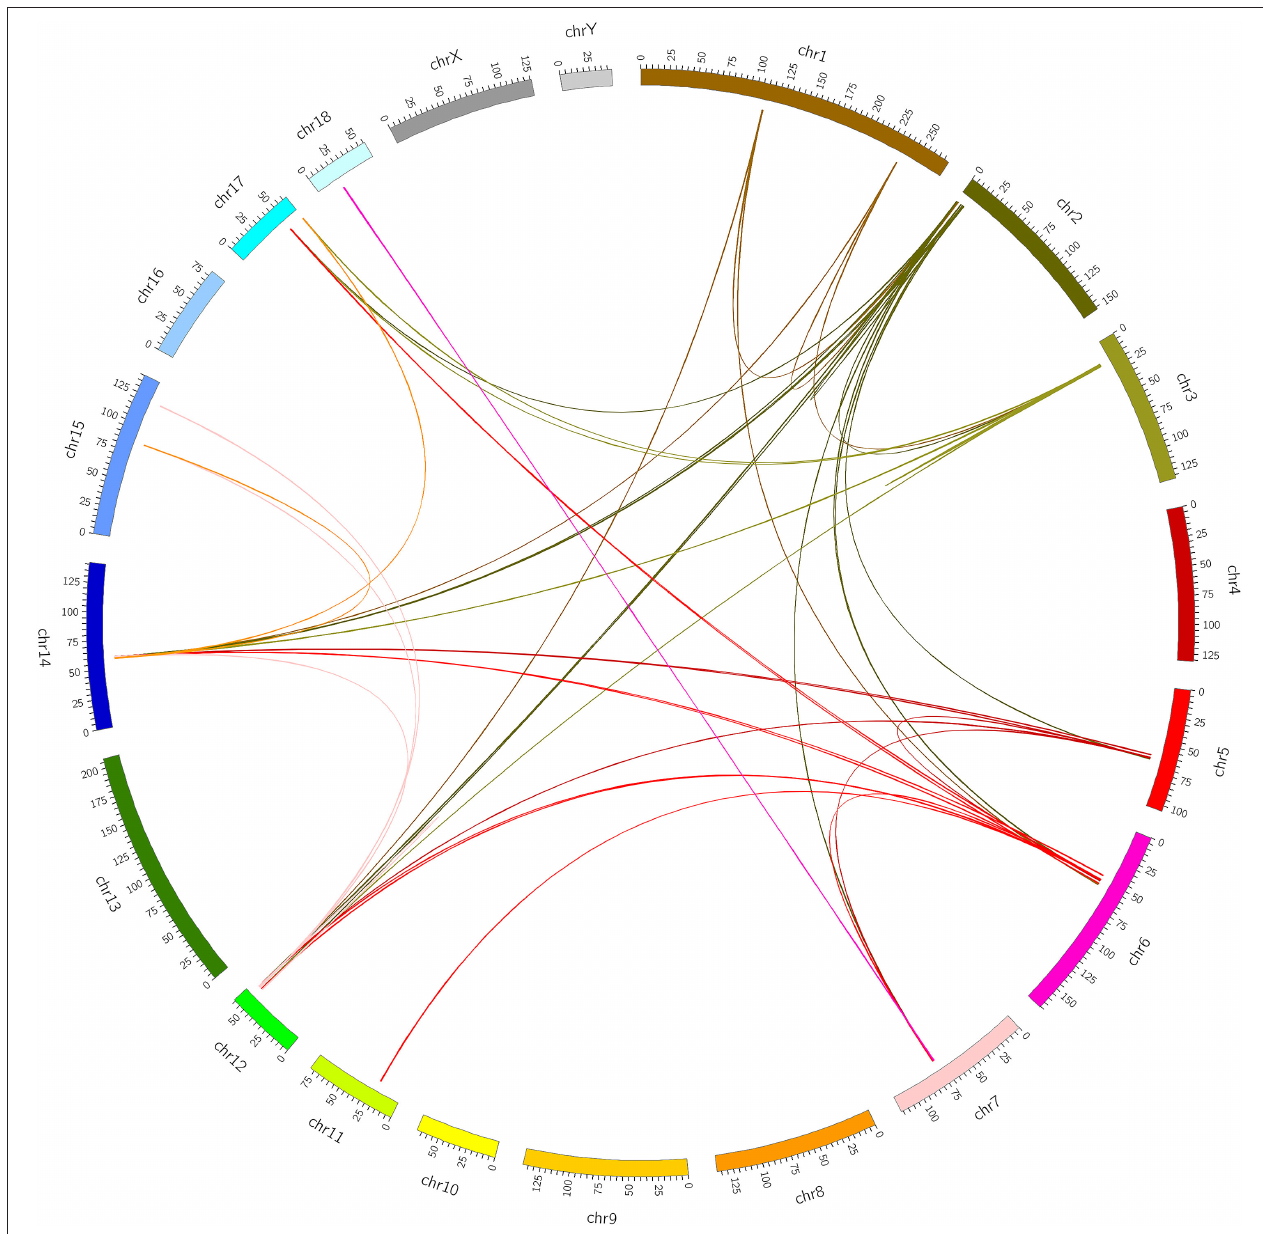
FIGURE 1 | Identification of chimeric RNAs in pig muscle tissue. Chimeric RNAs were plotted on Circos plots. The fused transcripts are illustrated here as a line that connects two parental genes.